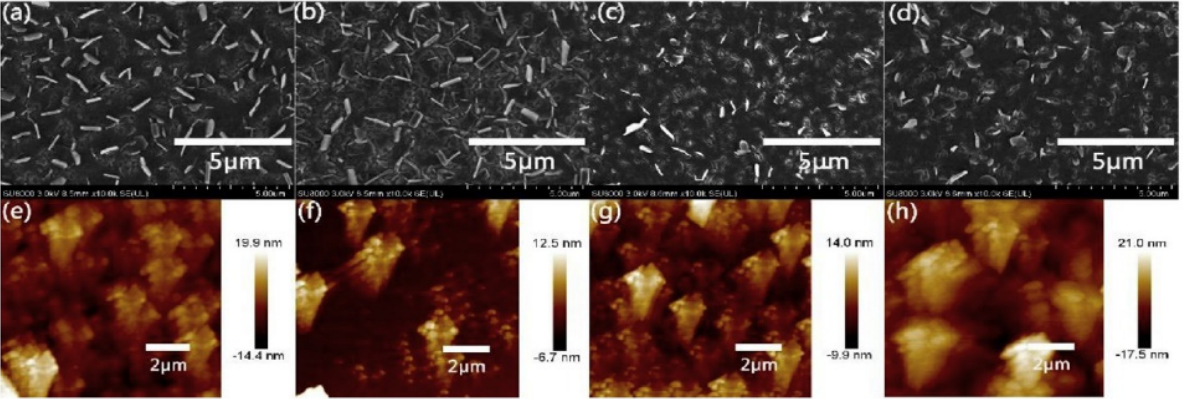
Figure 11. SEM images ( a – d ) and AFM images ( e – h ) of pentacene films prepared via thermoevaporation of pentacene on ITO substrates preheated at RT, 40 °C, 80 °C, and 120 °C, respectively. Reprinted with permission from ref. [86]. 2019